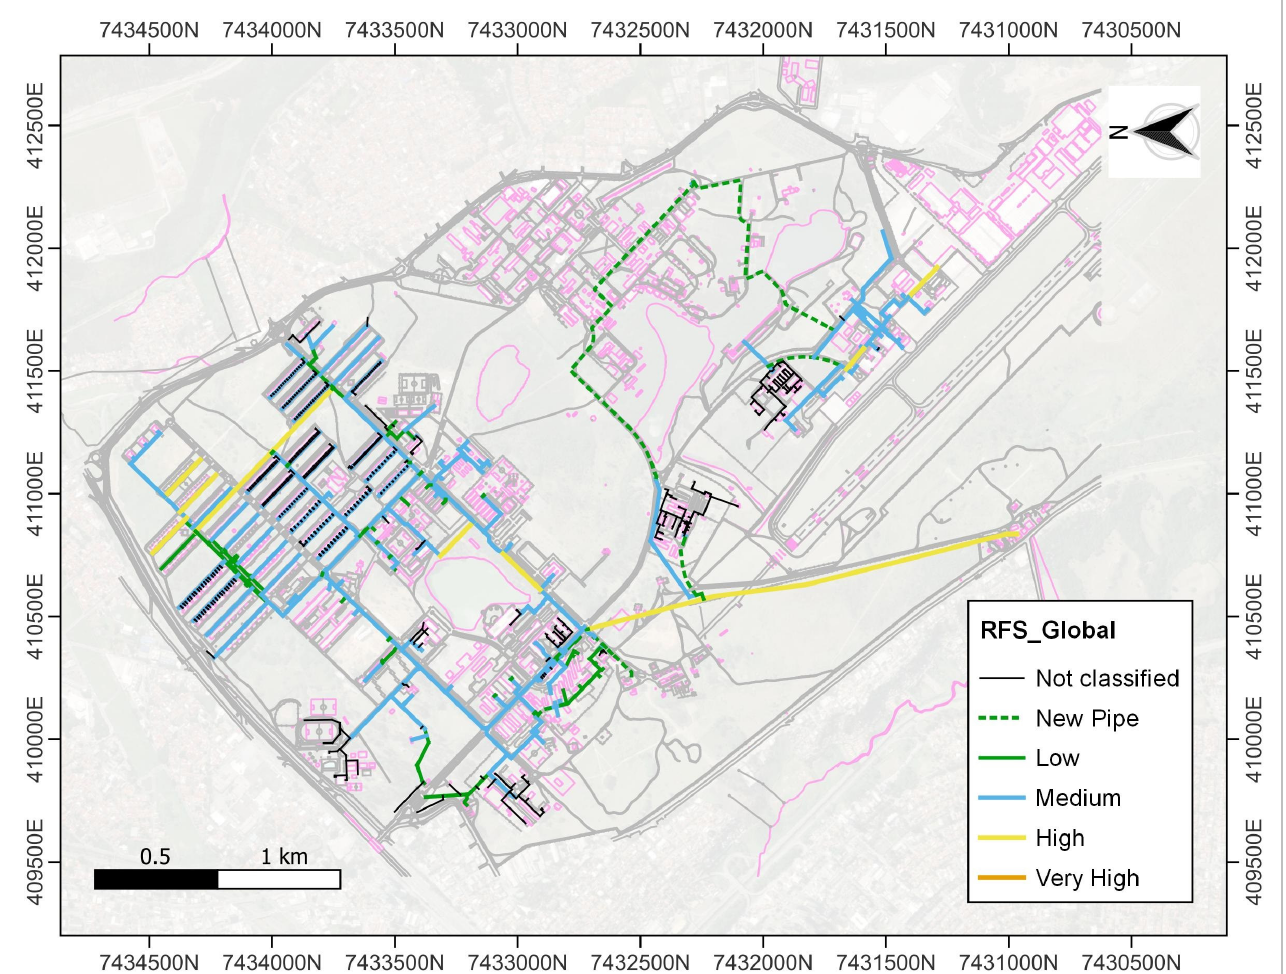
Figure 6. Water distribution network failure risk map.